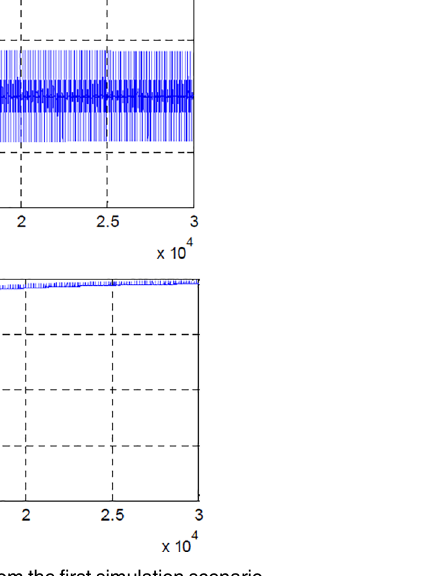
coefficients of initial plant function G ð s Þ ¼